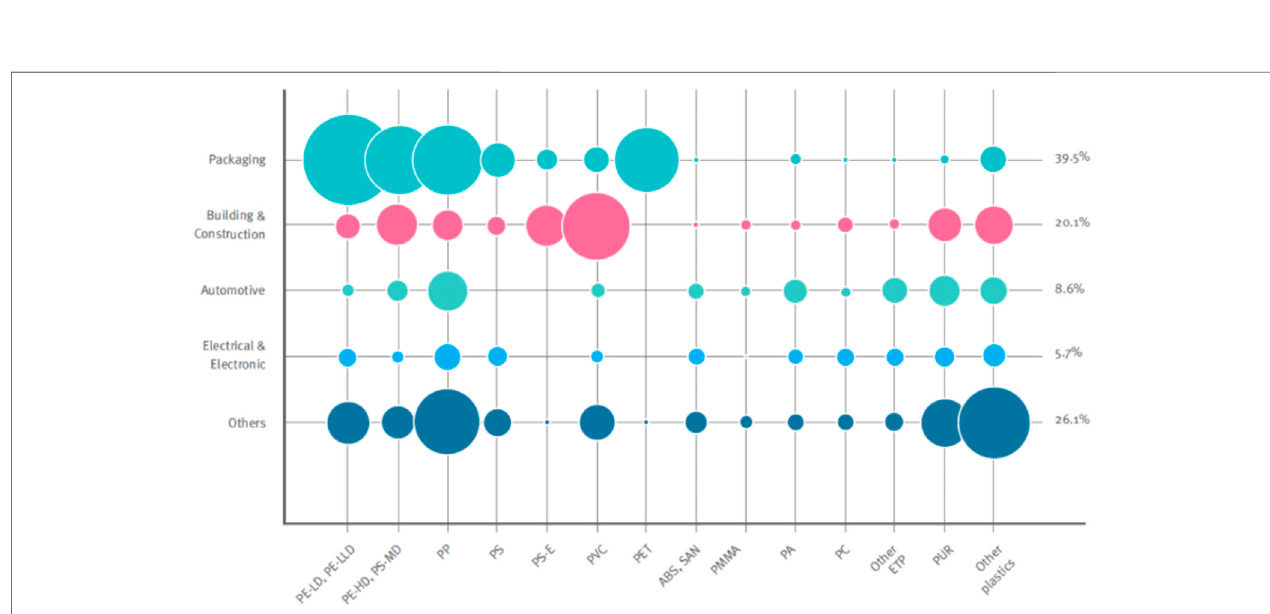
FIGURE 3 | Categorization of plastics based on demand per sector and polymer type (PlasticEurope, 2015).